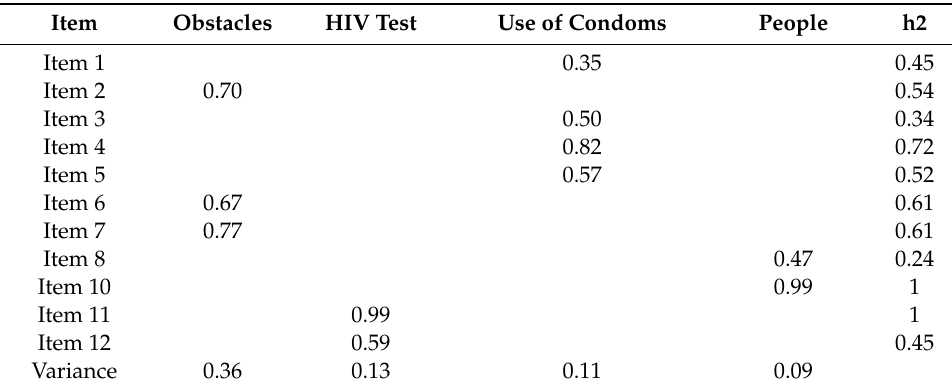
Table 3. Component rotation matrix, communalities (h 2 ).